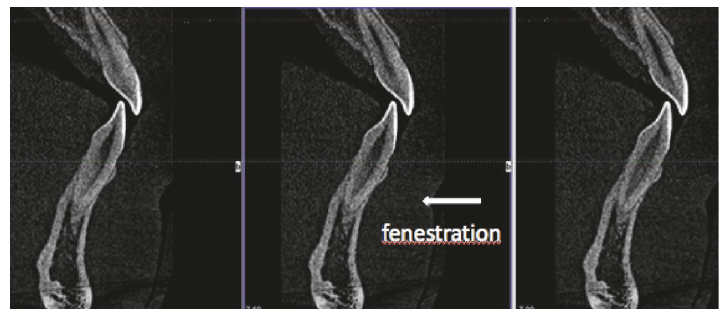
Figure 1: Cone-beam computed tomography (CBCT) images showing fenestrations in the area of the incisors.